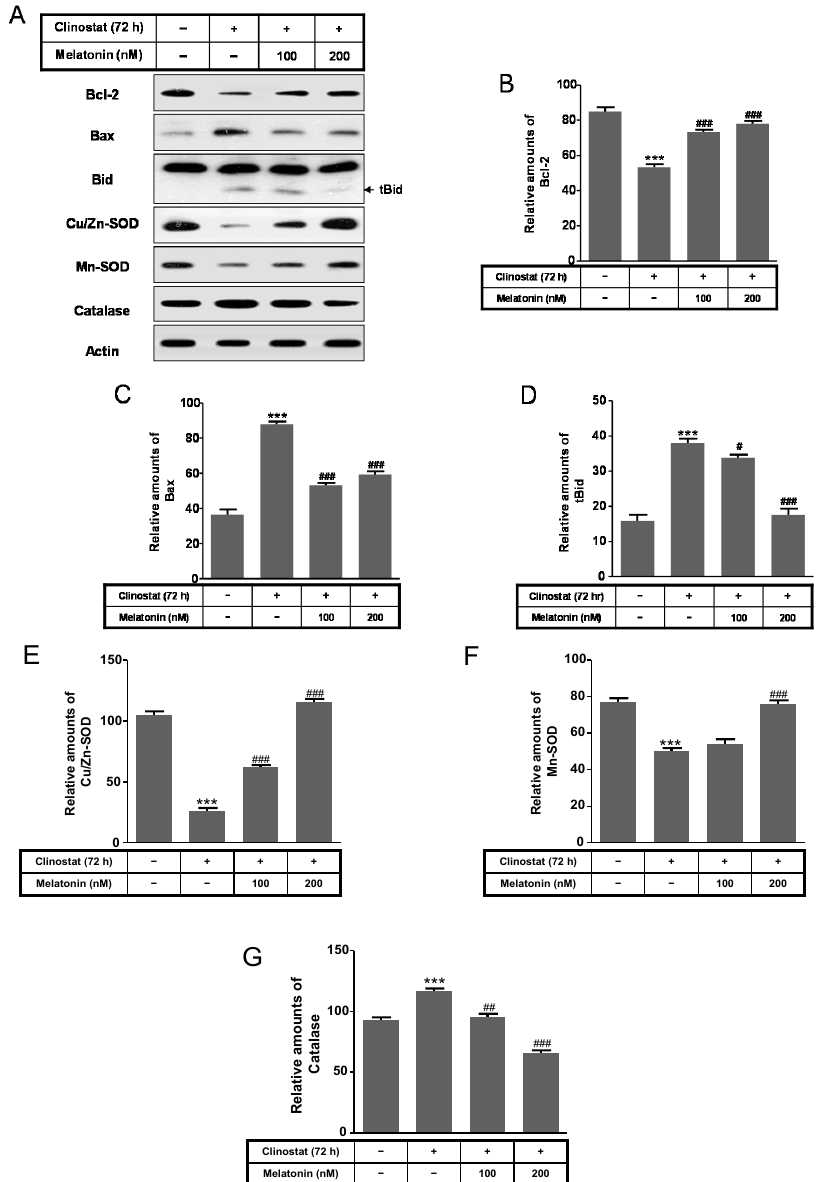
endoplasmic reticulum (ER) stress marker GRP78/BiP, IRE1 α , and p-PERK were significantly reduced in melatonin-treated clinostat samples (Figure 5).